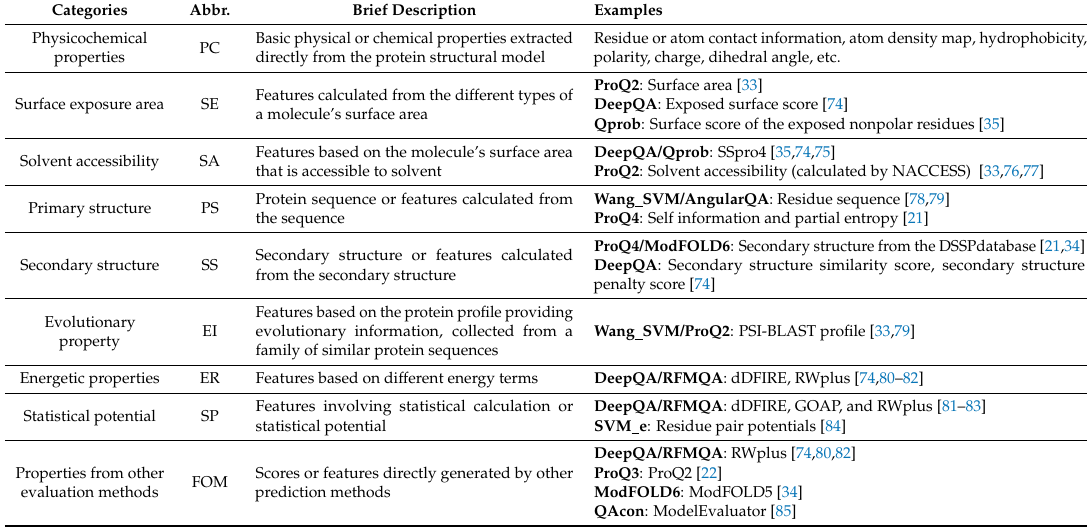
Table 2. Categories of commonly used features in ML-based EMA